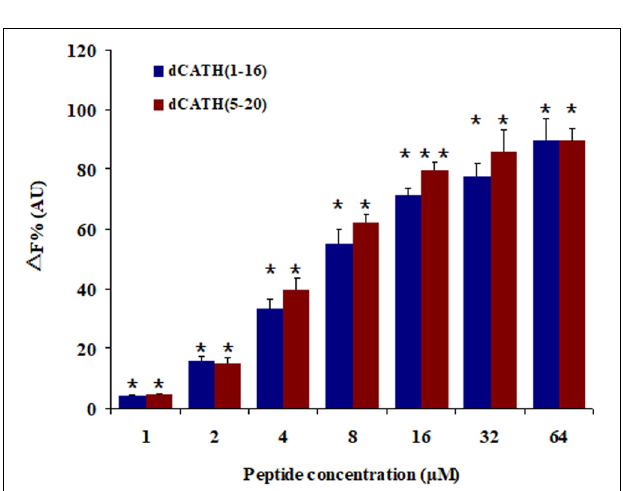
FIGURE 6 | Peptide binding affinity to LPS from E. coli 055:B5. The combining ability of dCATH (1–16) and dCATH (5–20) (1, 2, 4, 8, 16, 32, and 64 µ M) with LPS. The graphs were derived from average values of three independent trials. Means in the same concentration with different superscript are very significant difference ( P < 0.01).